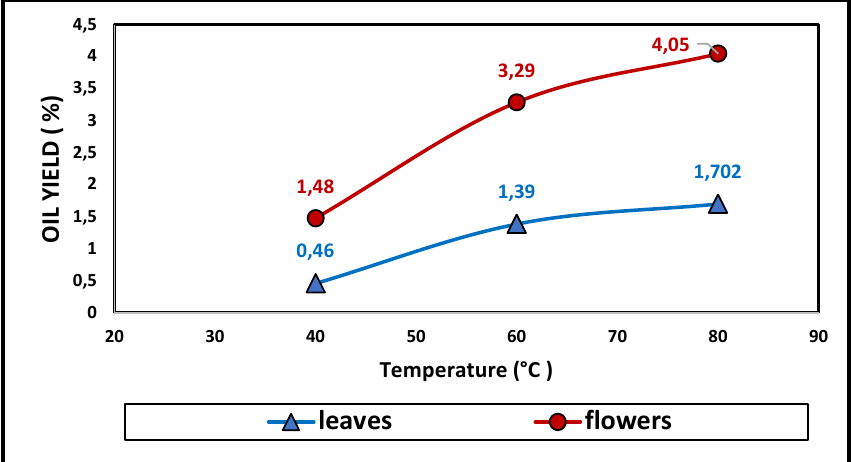
Figure 1. The effect of temperature on M. pulegium essential oil extraction operating conditions (volume